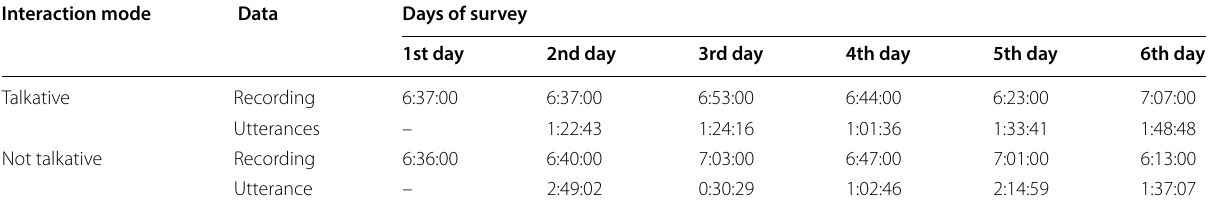
Table 3 Durations of recording and utterances for the utterance survey Interaction mode